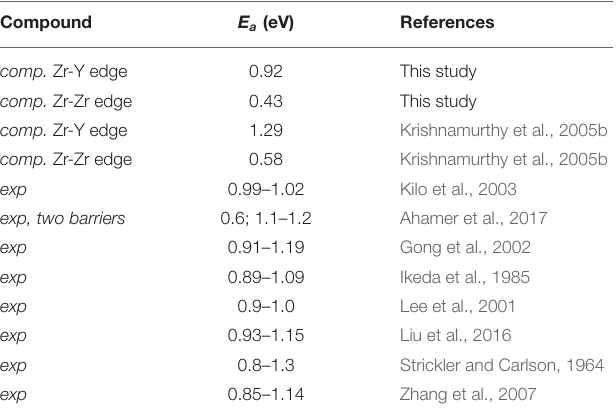
TABLE 6 | The computed here and previously published data on E a for ionic conductivity in Y-stabilized zirconia. Compound E a (eV)